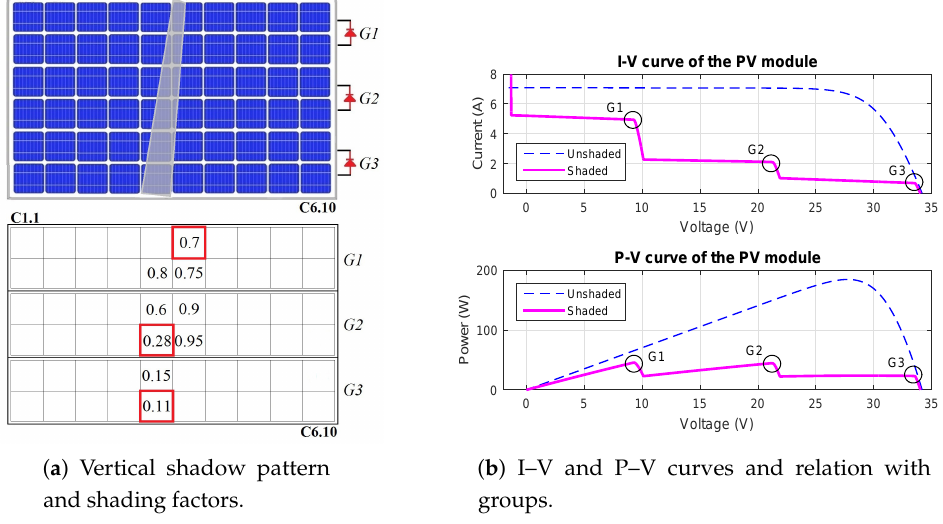
Figure 12. I–V and P–V behavior of the vertical shadow pattern in a PV module. Table 2. Maximum power points—Case: vertical shadow. Parameter